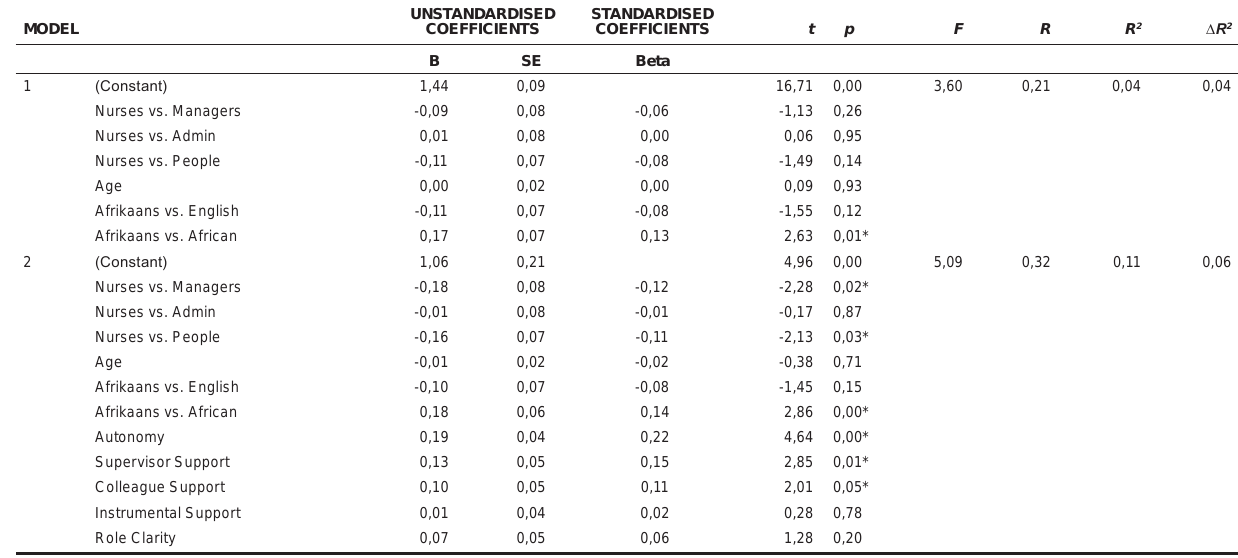
taBLe 5 Multiple regression analyses with positive WHI as dependent